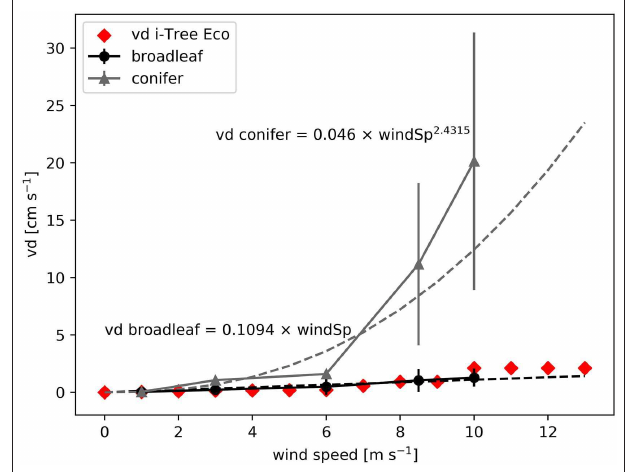
FIGURE 1 | Deposition velocities (vd) of coniferous and broadleaved tree types in dependence on wind-speed (windSp). Values represent averages from Tables 1 , 2 with the standard deviations given as uncertainty ranges. Red diamonds indicate the relationship as implemented in the original i-Tree model.